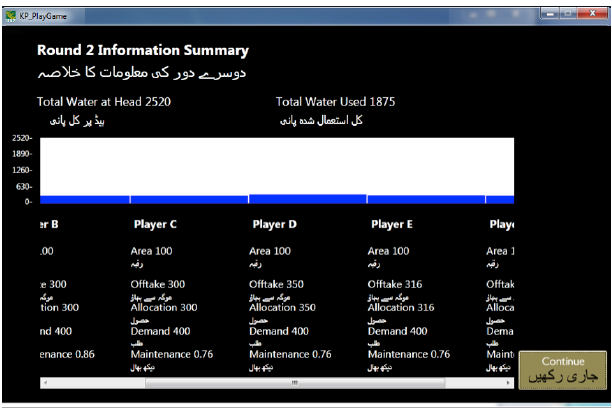
Fig. 5 . Between-round information screen from information